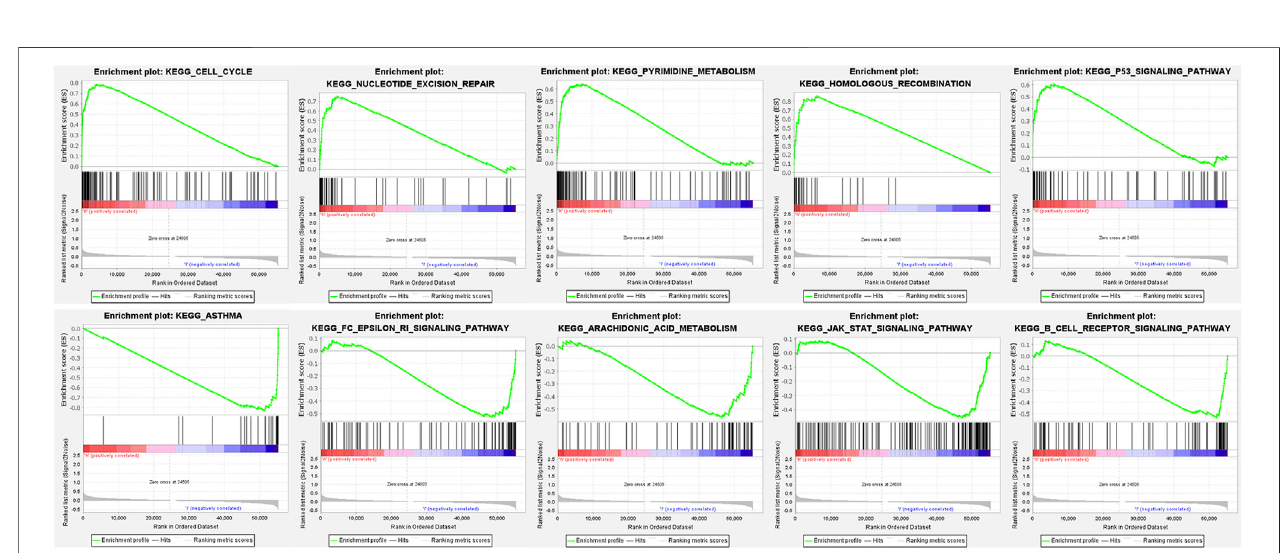
FIGURE 5 | Functional enrichment analysis of genes between high-risk and low-risk groups based on the TCGA tumor dataset.